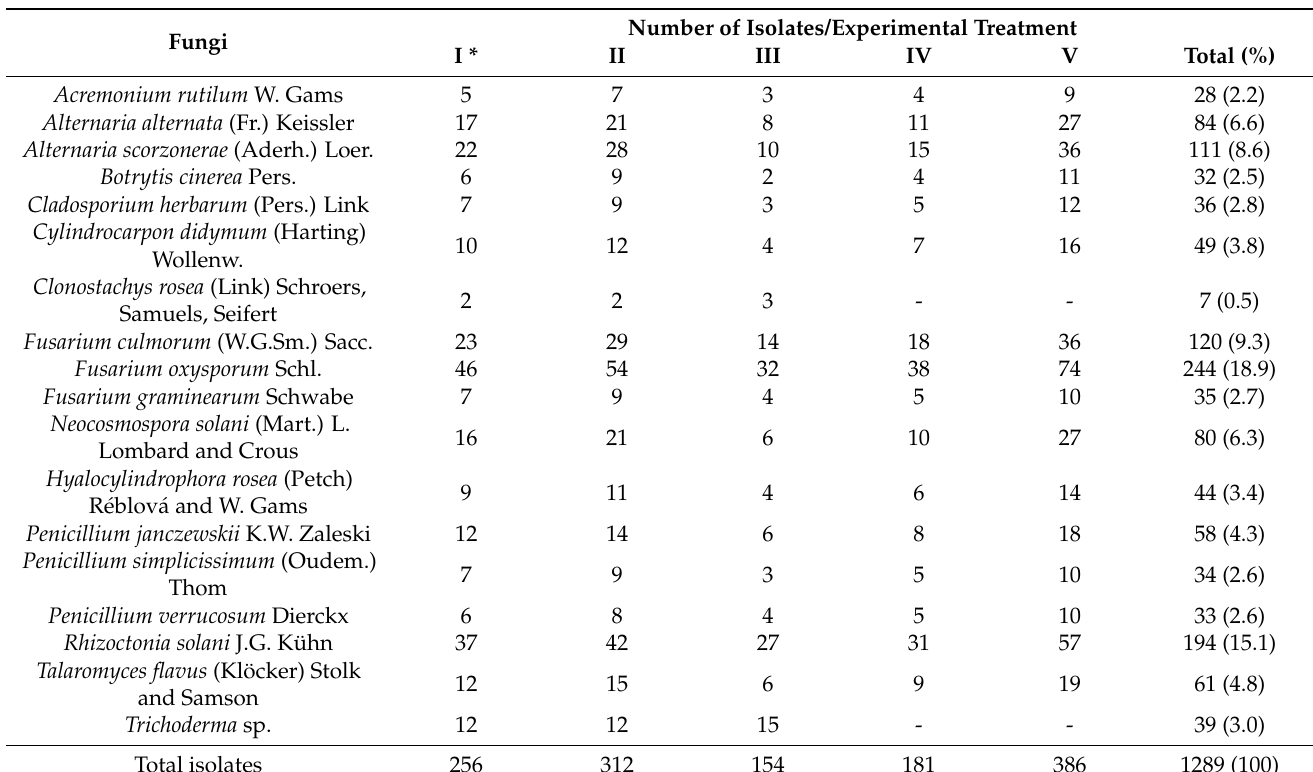
Table 2. Fungi isolated from diseased scorzonera seedlings (sum 2014–2016). Number of Isolates/Experimental Fungi